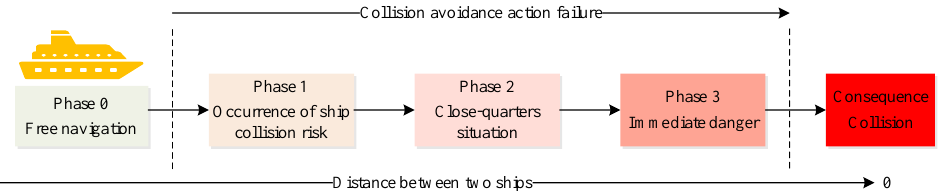
Figure 2. Ship encounter phases.